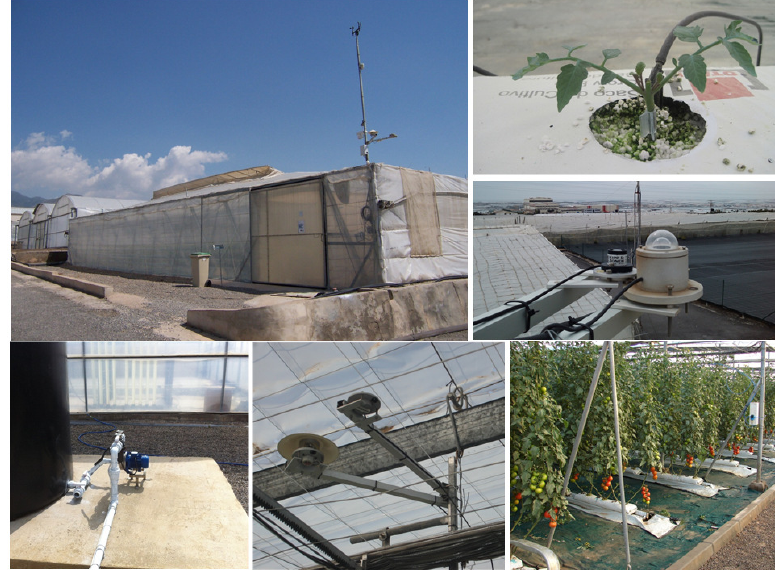
Figure 2. Greenhouse and acquisition data system.